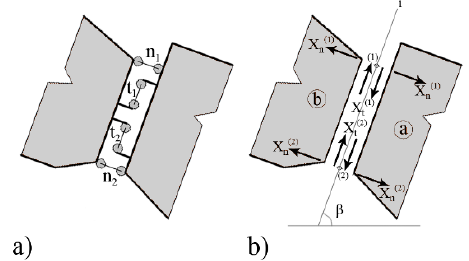
Figure 11. Joint device between block ‘a’ and ‘b’ of the mechanical